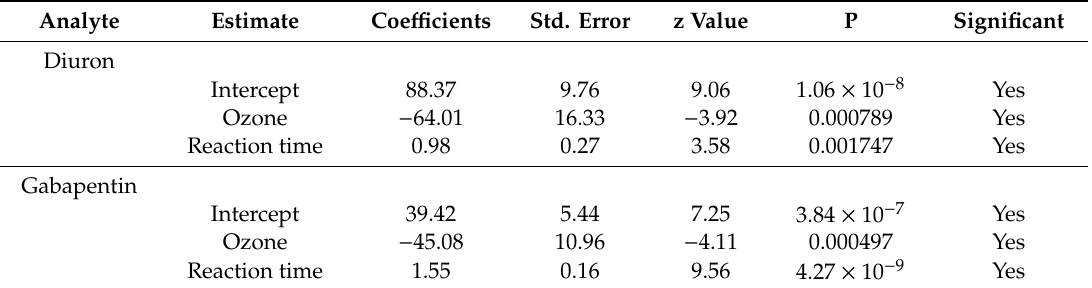
Table 7. Gaussian distribution analysis without considering parameters interactions. Analyte Estimate Diuron